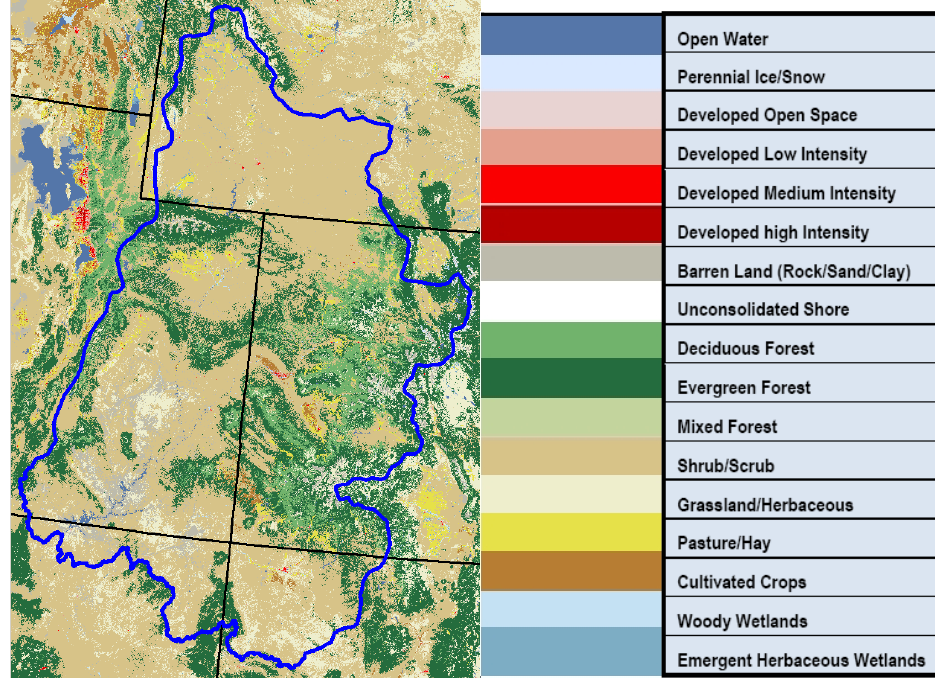
Figure 1. Study area and land cover type